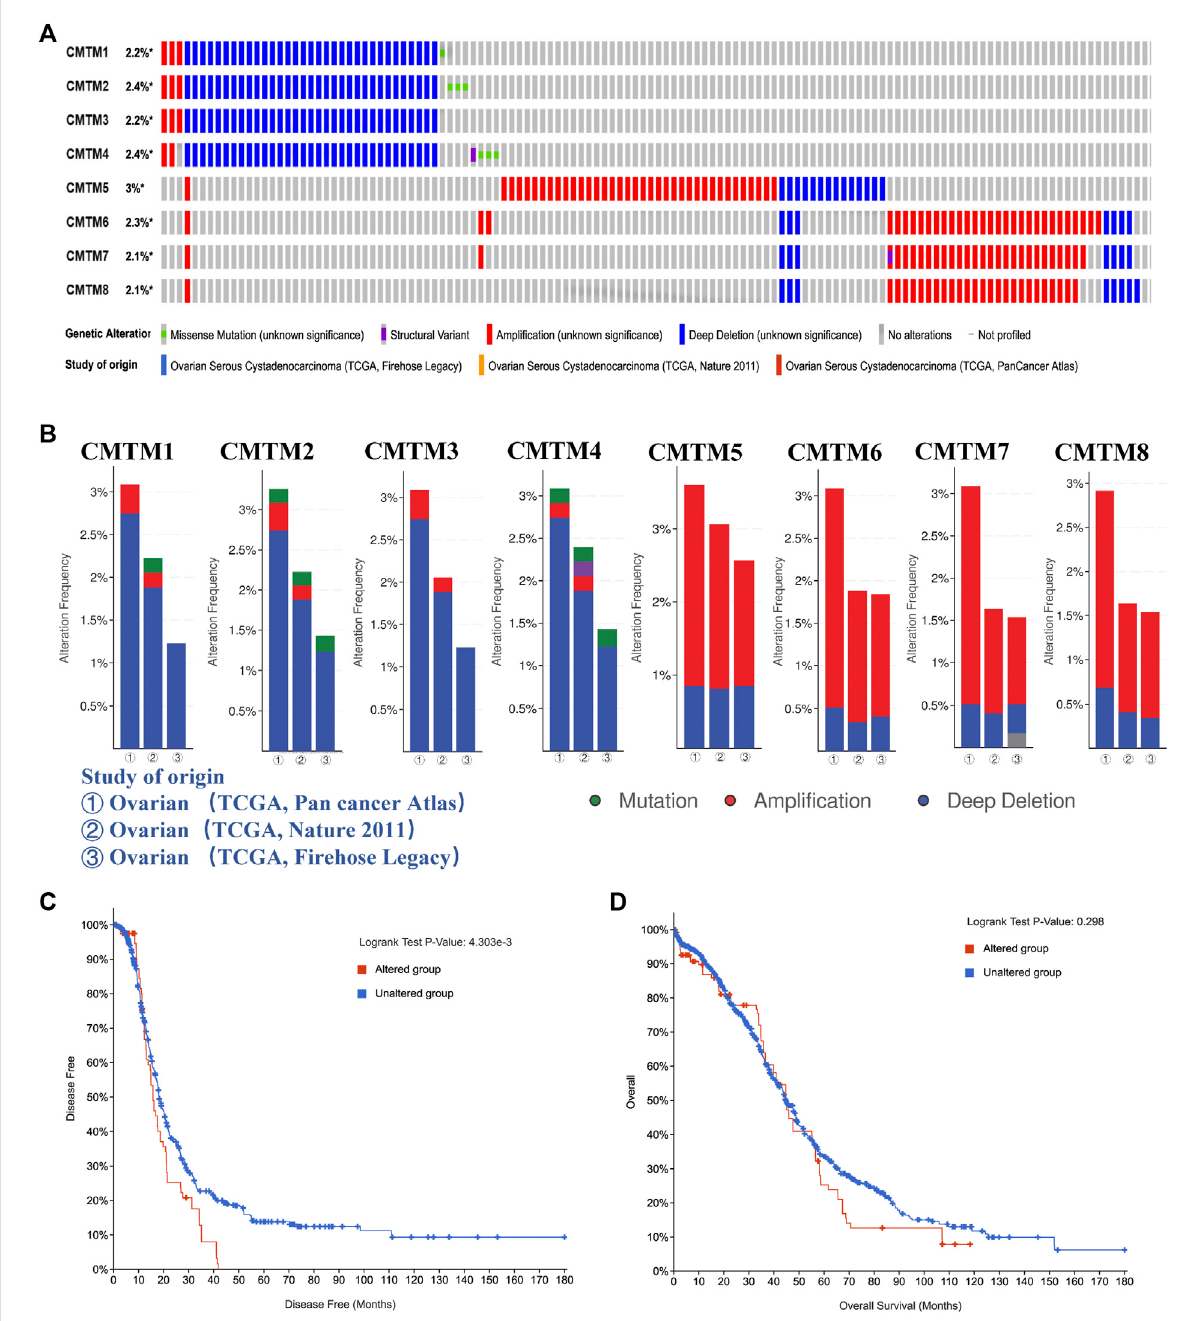
FIGURE 6 The genetic alteration of the members of the CMTM family in ovarian cancer and their effects on the prognosis. (A) Percentage of clinical samples with genetic alterations in ovarian cancer for each member of the CMTM family, including missense mutations, structural variants, ampli fi cations, and deep deletions. For example, CMTM3 has genetic alterations in 2.2% of clinical samples, among which ampli fi cations and deep deletions are the main ones, and the number of clinical samples with deep deletions is signi fi cantly higher than the number of clinical samples withampli fi cations. (B) Geneticalterationinthreestudycohorts,includingTCGAPanCancerAtlas,TCGANature2011andTCGAFirehoseLegacy. (C) Disease-free survival curves of ovarian cancer patients in the gene altered group and the gene unaltered group. (D) Survival curve of the overall survival time of ovarian cancer patients in the gene altered group and the gene unaltered group. p < 0.05 was considered statistically signi fi